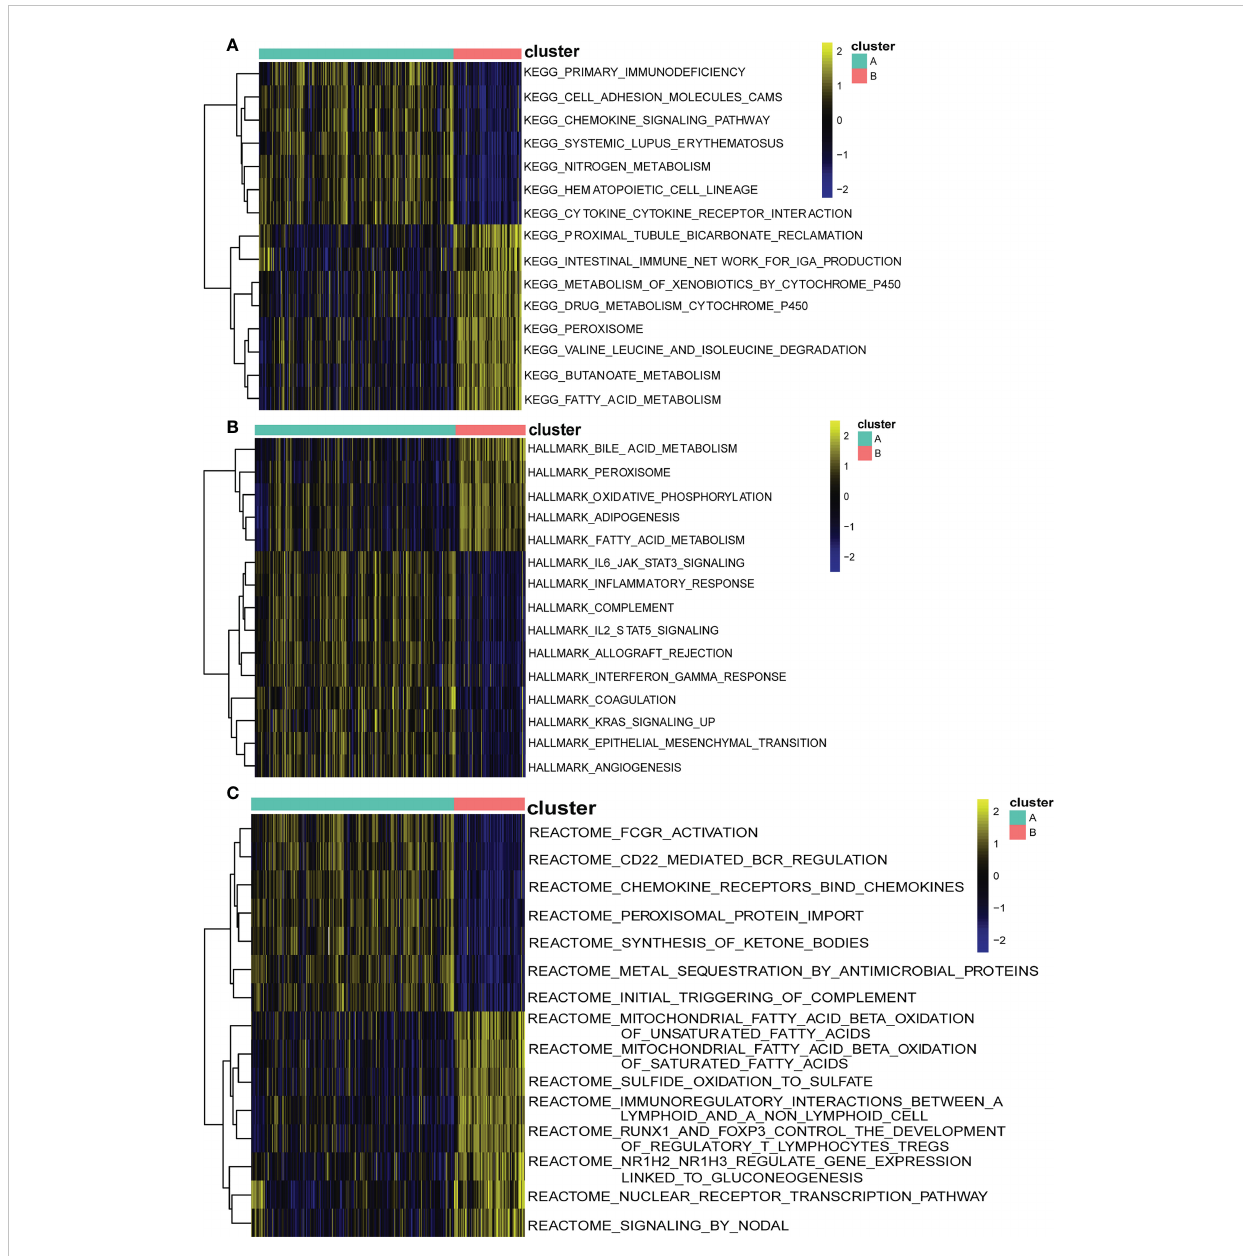
FIGURE 9 Biological characteristics of two distinct cuproptosis subtypes of UC revealed by GSVA. (A) Enriched pathways based on the KEGG pathway. (B) Enriched pathways based on the Hallmark pathway. (C) Enriched pathways based on the Reatcome pathway. Each row of the heatmap represents an enriched pathway, and each column represents a UC sample, either the A subtype or B